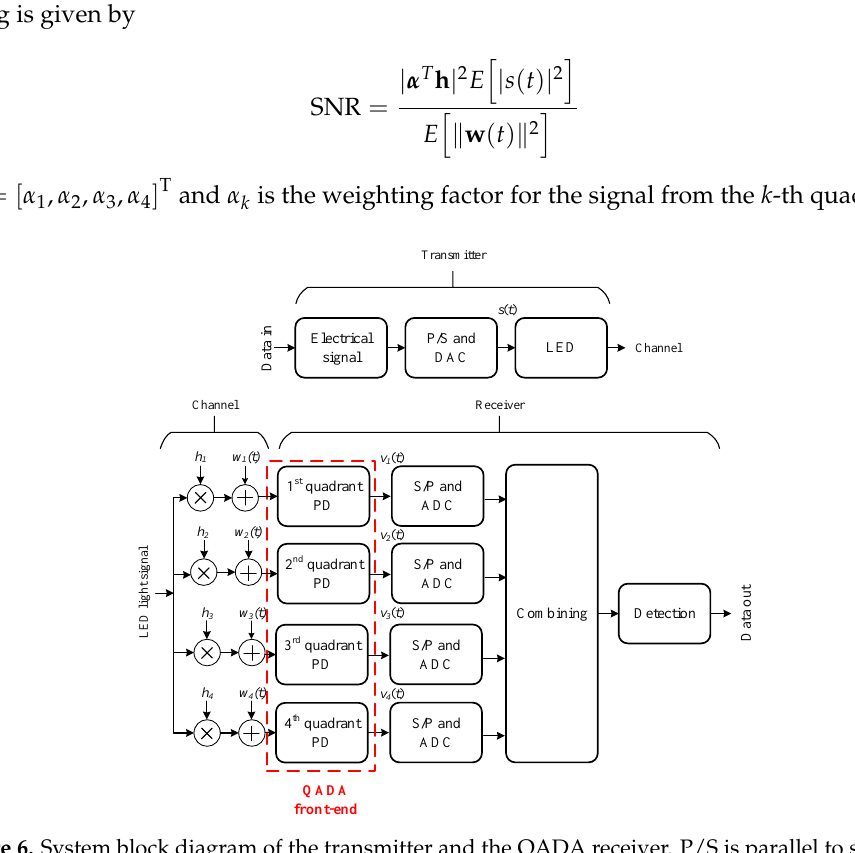
Figure 6. System block diagram of the transmitter and the QADA receiver. P/S is parallel to serial and S/P is serial to